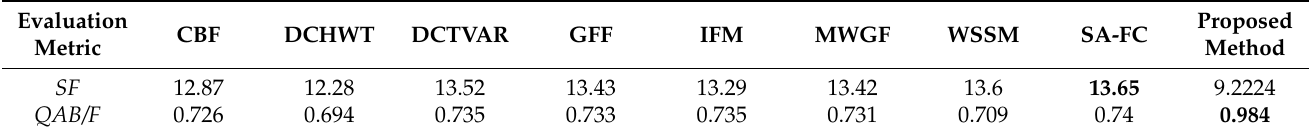
Table 8. The outcomes for the clock image and comparisons with existing techniques in the literature